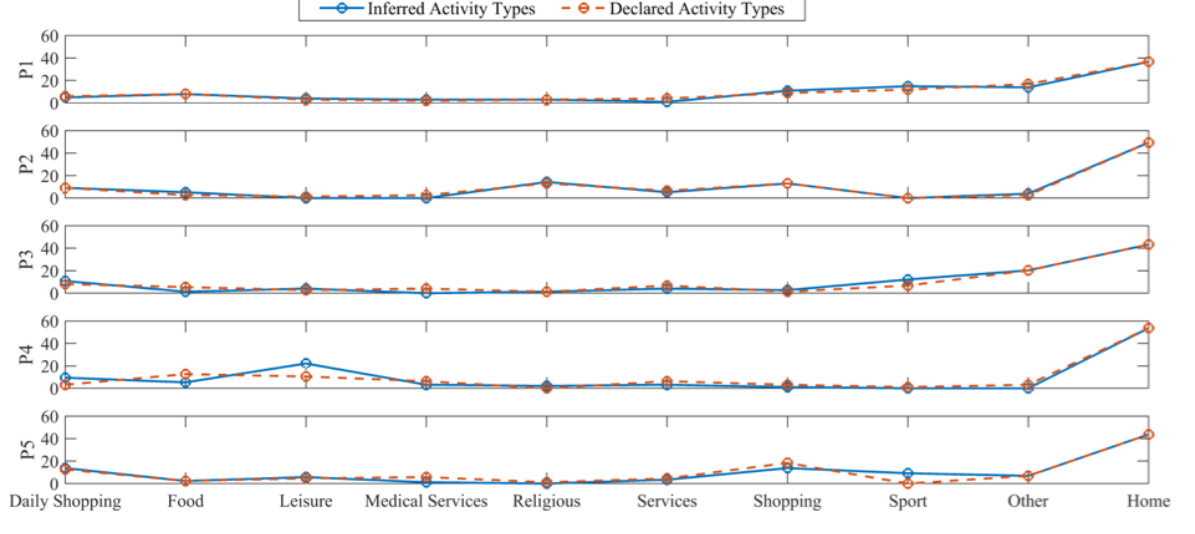
Figure 7. Comparison of the number of activity types in the travel diary versus the ones inferred from the GPS data for Participants 1 to 5